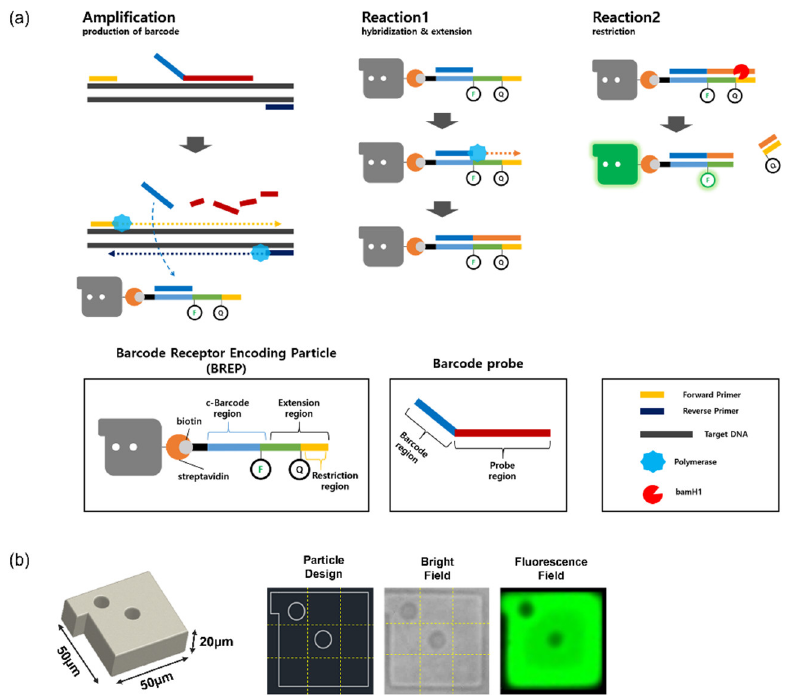
Figure 1. ( a ) Schematic illustration of Barcode Receptor Encoding Particle (BREP) assay. ( b ) Particle image and graphical encoding created with combinations of holes on square shape particles with a protruding